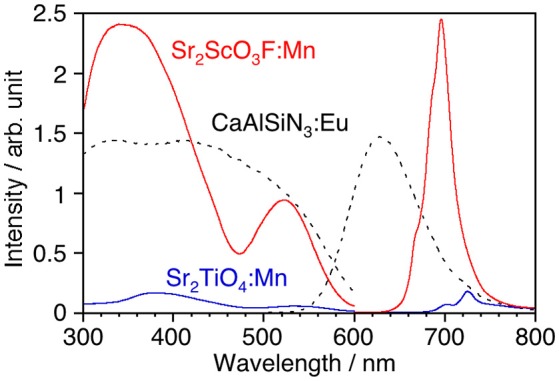
Luminescence spectra of Sr2TiO4:Mn, Sr2ScO3F:Mn, and CaAlSiN3:Eu with corresponding excitation spectra at room temperature. Excitation and monitored wavelengths were 380 and 725 nm for Sr2TiO4:Mn, 345 and 697 nm for Sr2ScO3F:Mn, and 340 and 630 nm for CaAlSiN3:Eu.